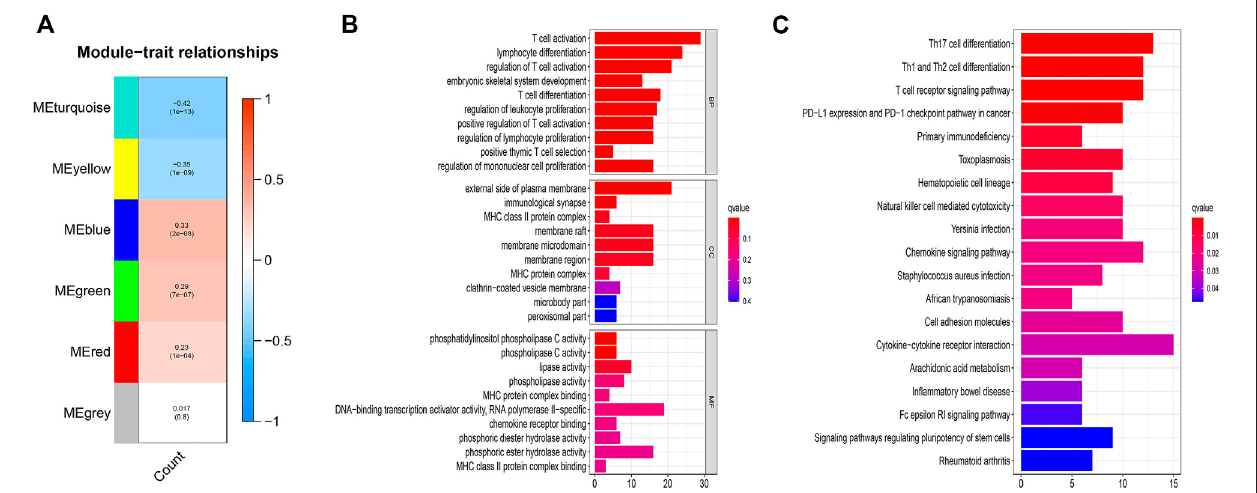
FIGURE 2 | (A) Correlation between the gene modules and CNSMs. Each cell contains a corresponding correlation coef fi cient and p value. The correlation coef fi cient decreased in size from red to blue. (B) GO functional annotations for mRNAs co-expressed with lncRNAs. (C) KEGG enrichment analysis for mRNAs co- expressed with lncRNAs. CNSMs: cumulative number of somatic mutations; GO: Gene Ontology; KEGG: Kyoto Encyclopedia of Genes and